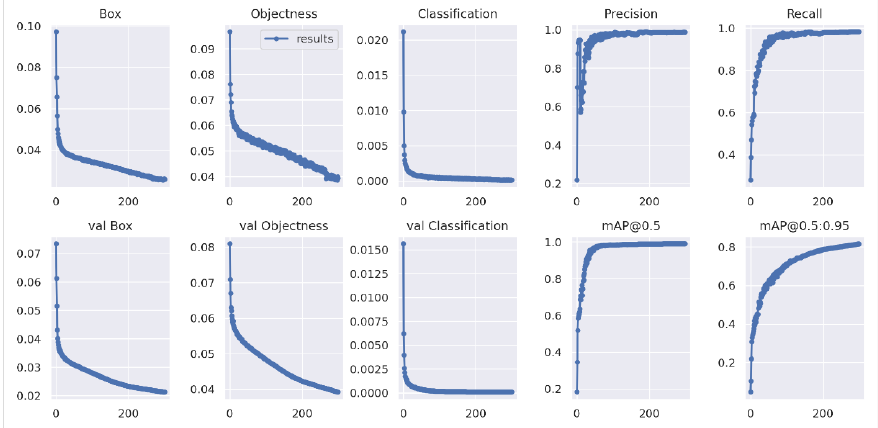
Figure 8. Training results of YOLOv5x on our proposed dataset.